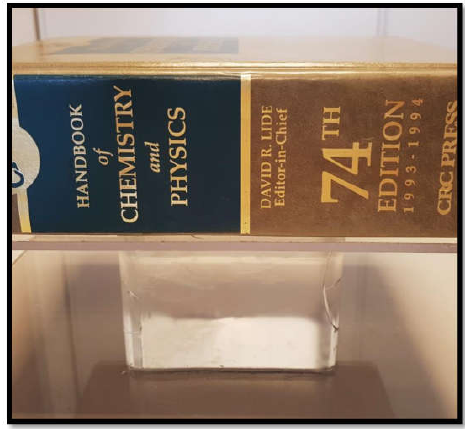
Figure 5. A 25 × 20 × 20 cm 3 -hydrogel block overlaid by a 3.2 kg weight (corresponding pressure of 10 −3 MPa).